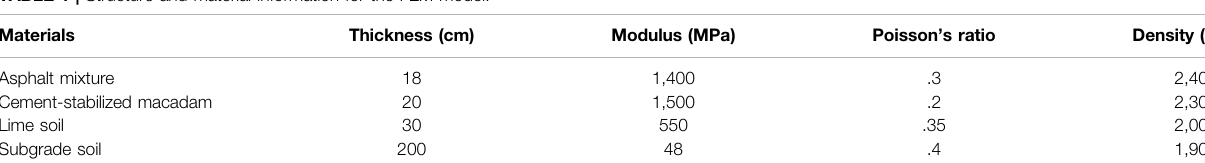
TABLE 1 | Structure and material information for the FEM model.